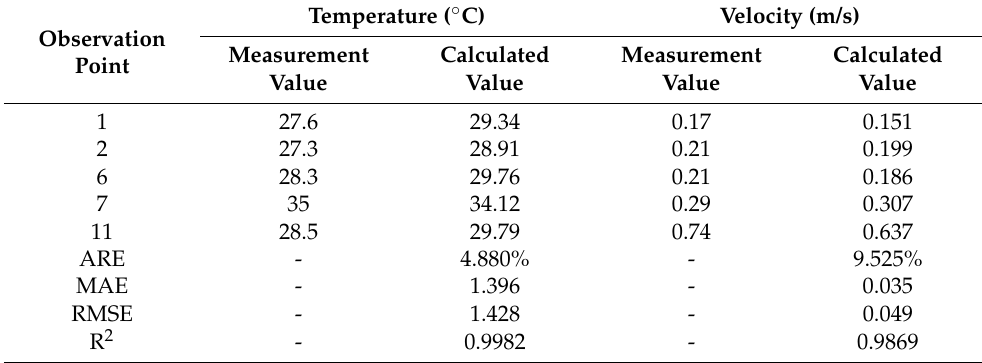
Table 3. CFD Validation.